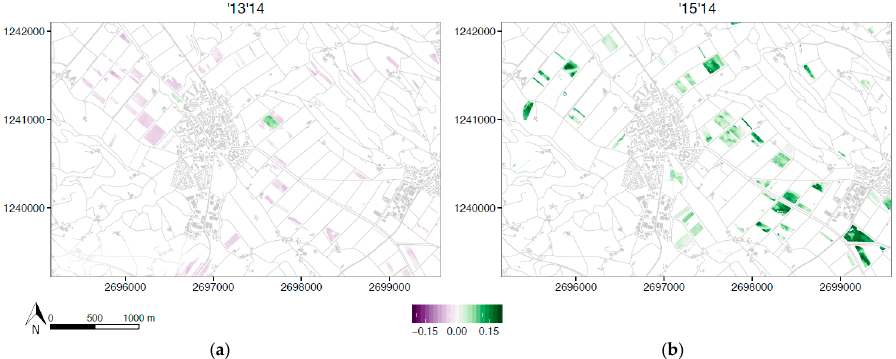
Figure 6. Spatial distribution in the focus area of the SMPE values for: ( a ) ‘13’14; and ( b ) ‘15’14.